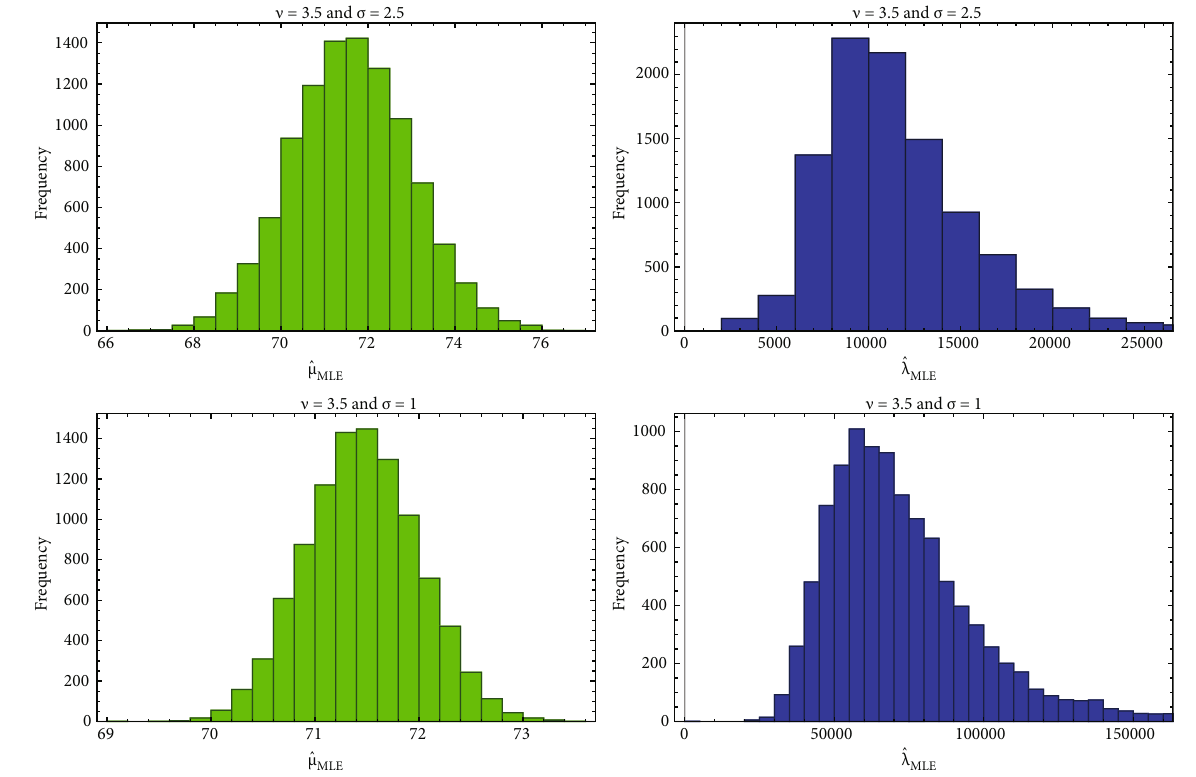
b λ and for n = 20 : MLE MLE